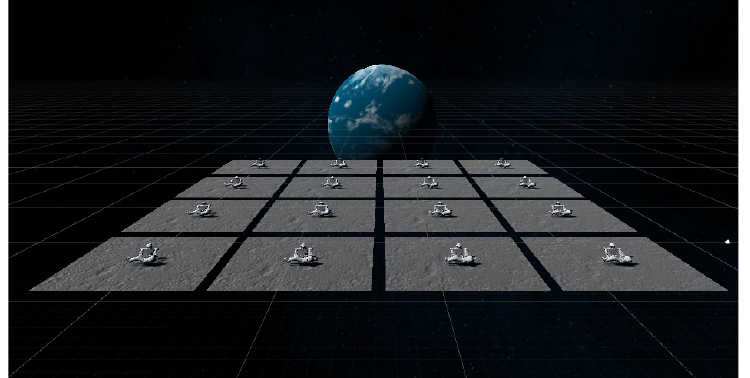
Figure 4. Training